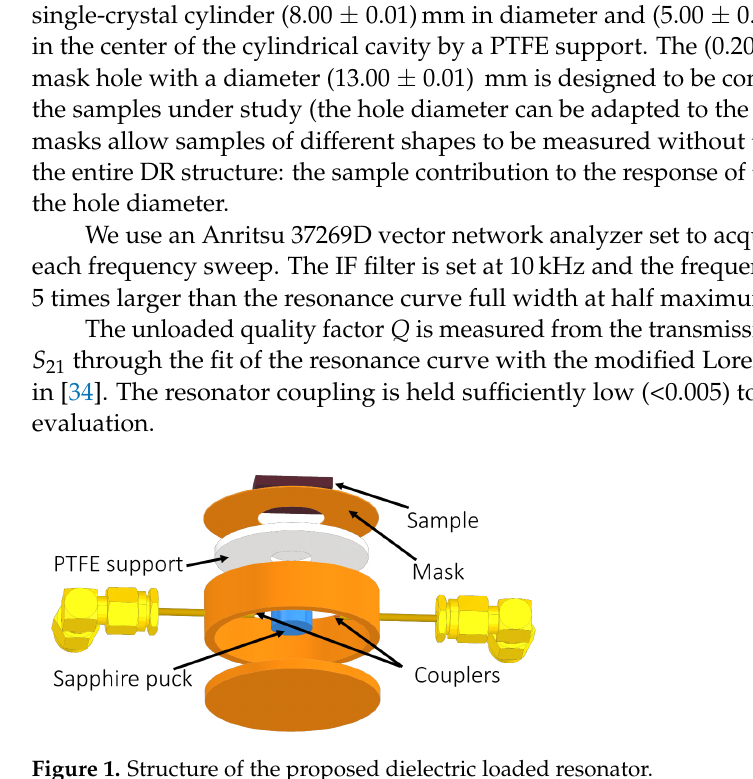
Figure 1. Structure of the proposed dielectric loaded